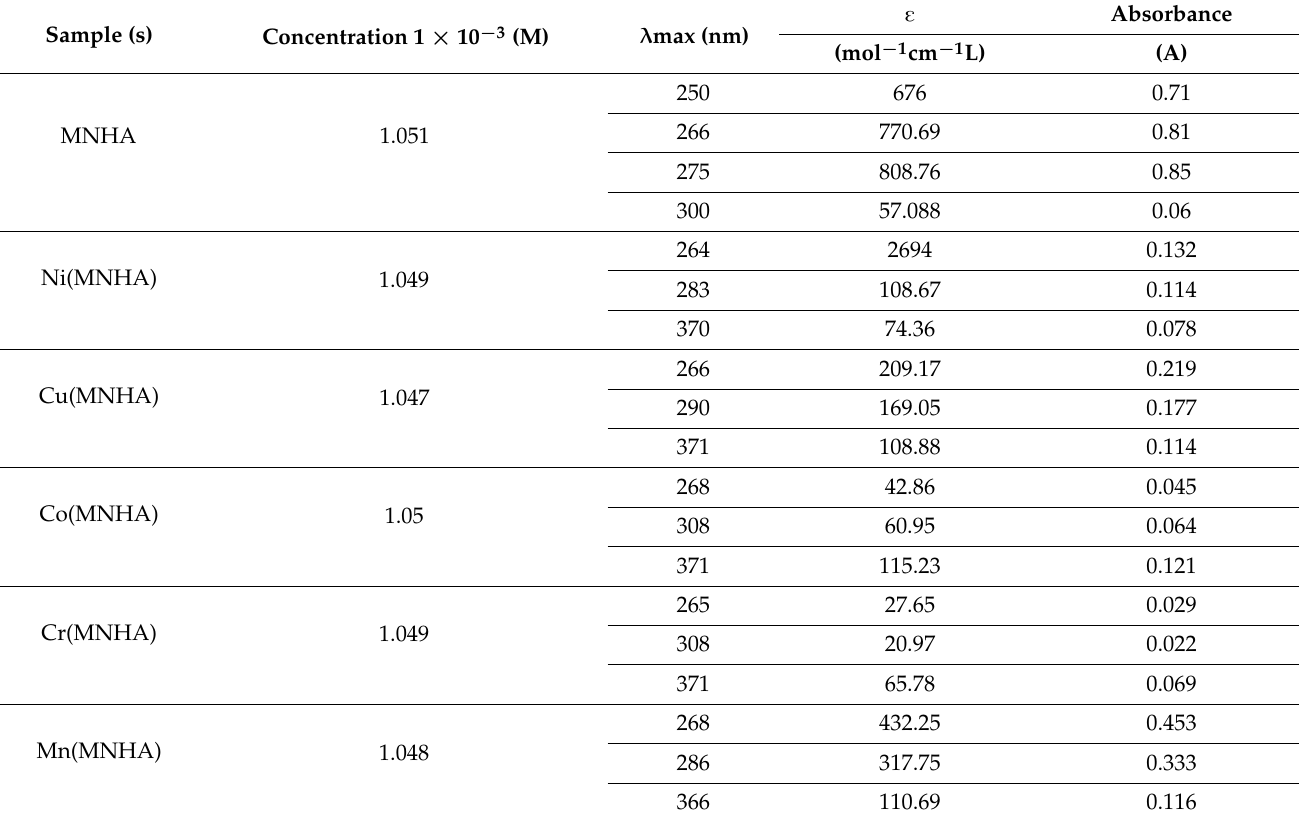
Table 2. Investigated UV–Vis spectroscopic data for the MBH adduct ligand (MNHA) and its formed